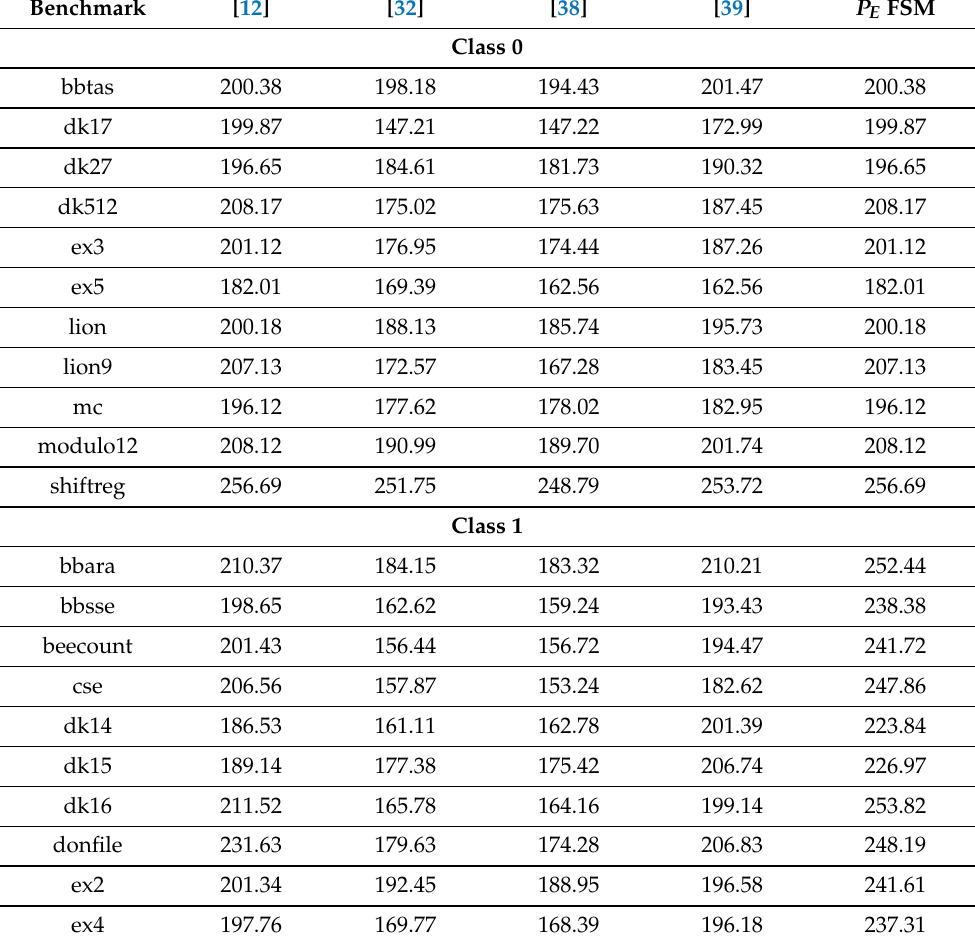
Table 14. Comparison with our previous works (maximum operating frequency, MHz).